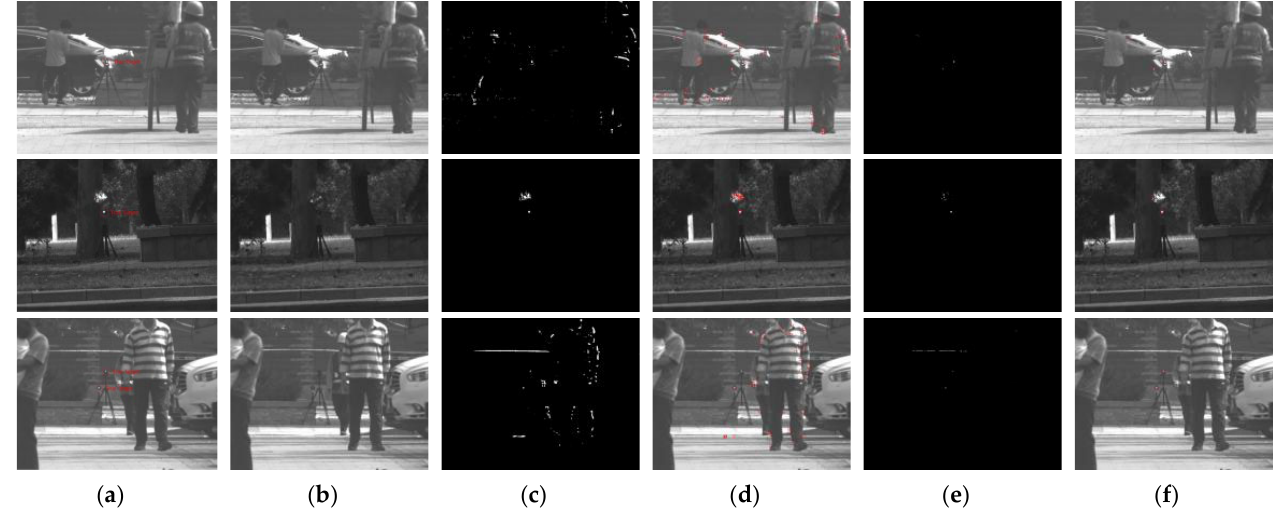
Figure 10. Network structure of the teacher and student models. ( a ) Resnet18 network structure (teacher model) and ( b ) Shuffv2_x0_5 network structure (student model).